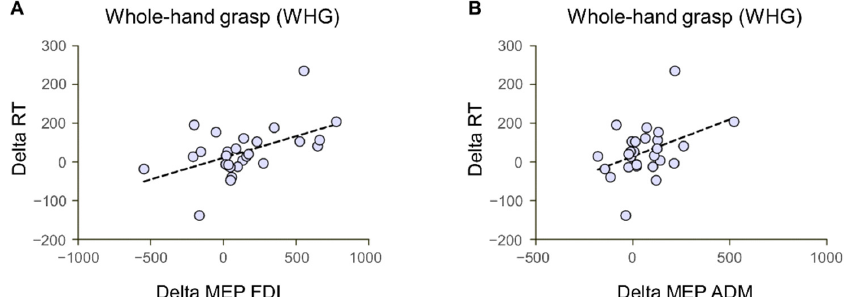
Figure 6. Correlations between MEP and RT delta values (Interactive—Non-Interactive condition). Both the differential index for the FDI ( A ) and ADM ( B ) MEP values positively correlated with the Reaction Times (RT) in the preparation of whole-hand grasps.